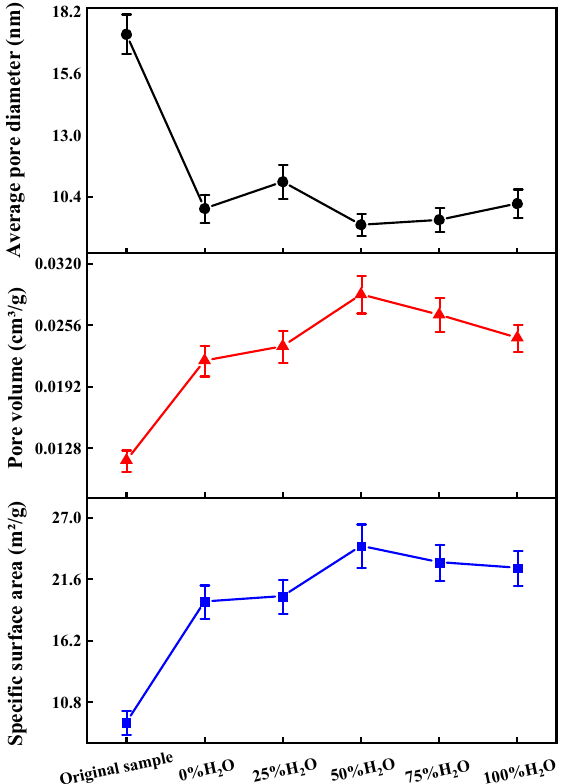
Figure 5. Stomatal parameters of coke reacting with different ratios of CO 2 and H 2 O.